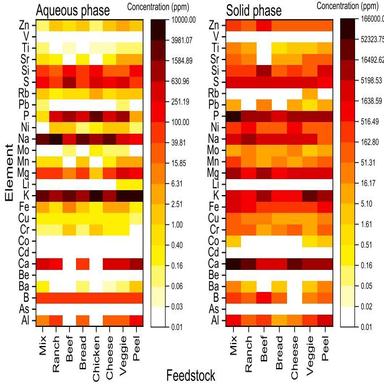
Heat map quantifying various metals and elements measured in the (a) aqueous and (b) solids phase of the optimized HTL reaction conditions for each of the different food waste feedstocks.